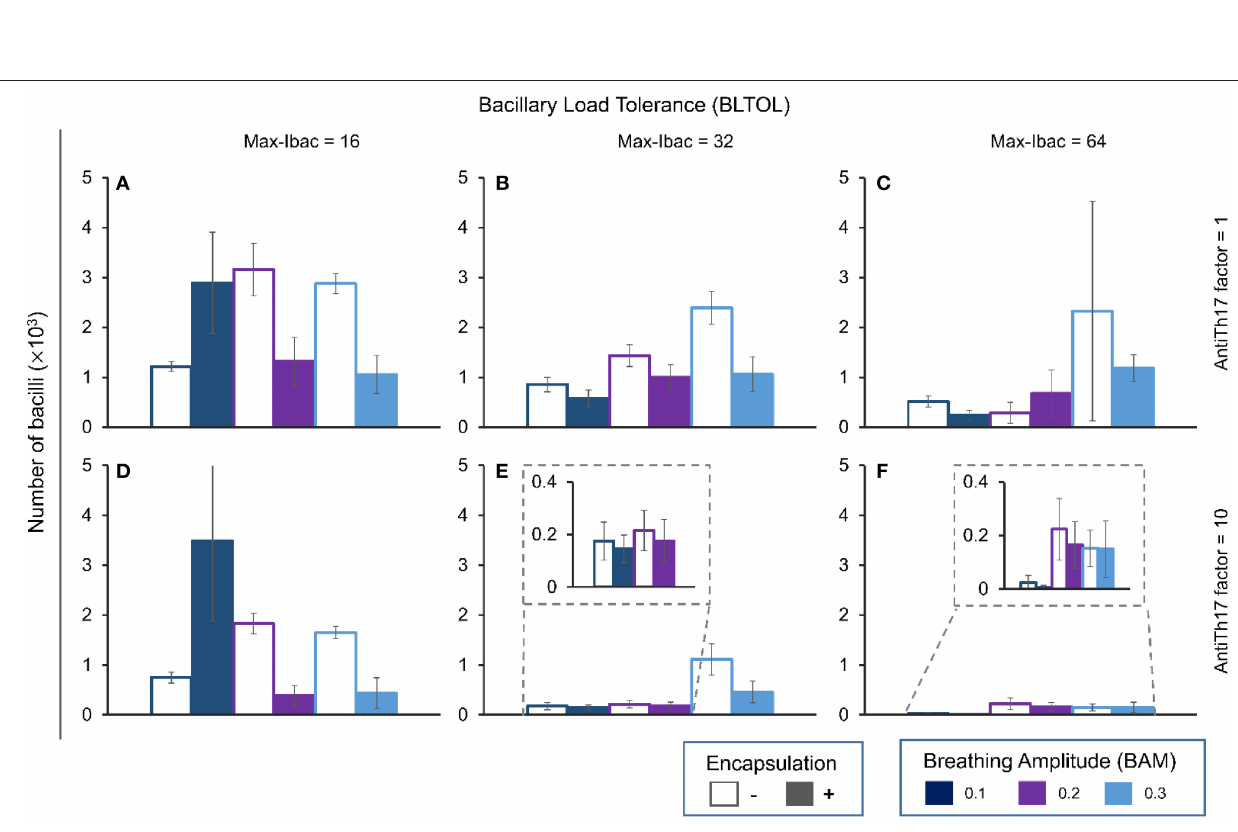
FIGURE 4 | Influence of different parameters on the number of intracellular bacilli at day 42. Maximum bacillary load per macrophage (BLTOL): 16 (A,D) , 32 (B,E) , 64 (C,F) . AntiTh17 factor: 1 (A–C) , 10 (D–F) Encapsulation factor: − , no encapsulation, + , encapsulation. Breathing amplitude (BAM): 0.1, 0.2, 0.3. Bars indicate the mean of 10